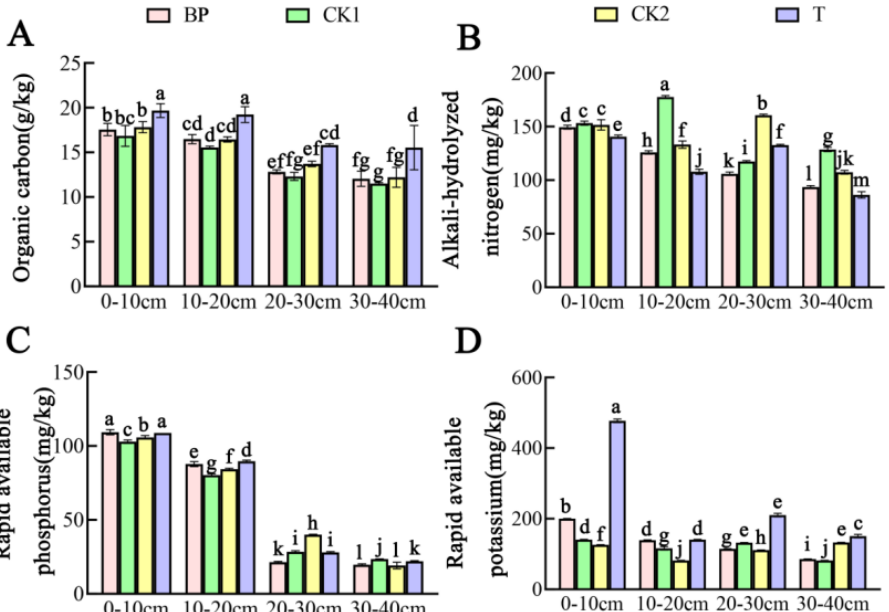
Figure 6. Trends of the nutrient contents at different soil layers under different rice straw mulching treatments. BP, before planting taro; AH, after harvest. CK1: taro seedlings were directly planted in the rows without mulching with film or straw, and fertilizer combined with soil was applied around the plant at the taro expansion stage. CK2: seedlings were covered with black mulching film. At the taro expansion stage, the mulched film was removed and fertilizer combined with soil was applied around the plant. T: seedlings were directly planted on the rows, the fertilizer combined with rice straw mulching at 15,000 kg/ha was applied on the row surface at the taro expansion stage. ( A ), the organic carbon of the soil; ( B ), the alkali-hydrolyzed nitrogen of the soil; ( C ), the rapid available phosphorus of the soil; ( D ), the rapid available potassium of the soil. Data are means ± SD (n = 3). The different lowercase letters in the figure indicate significant differences between the